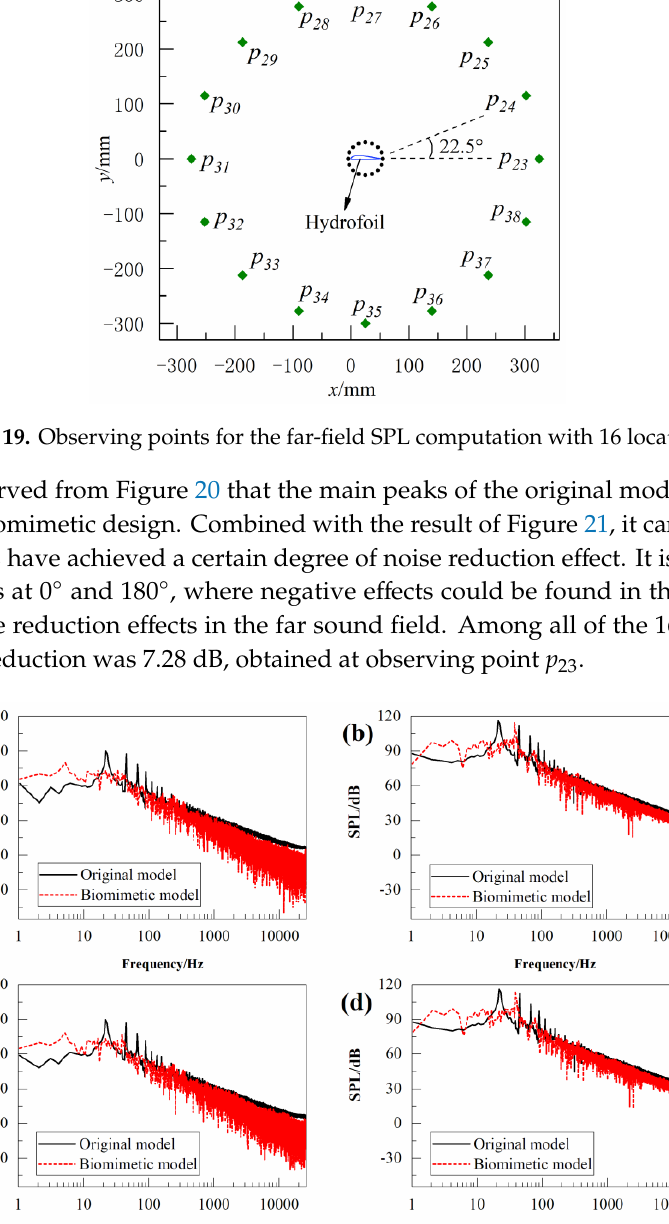
Figure 20. Comparison of the predicted SPL spectra of the original hydrofoil and biomimetic hydrofoil at the four observing points of the far sound field: ( a ) p 24 ; ( b ) p 28 ; ( c ) p 32 ; and ( d ) p 36 .